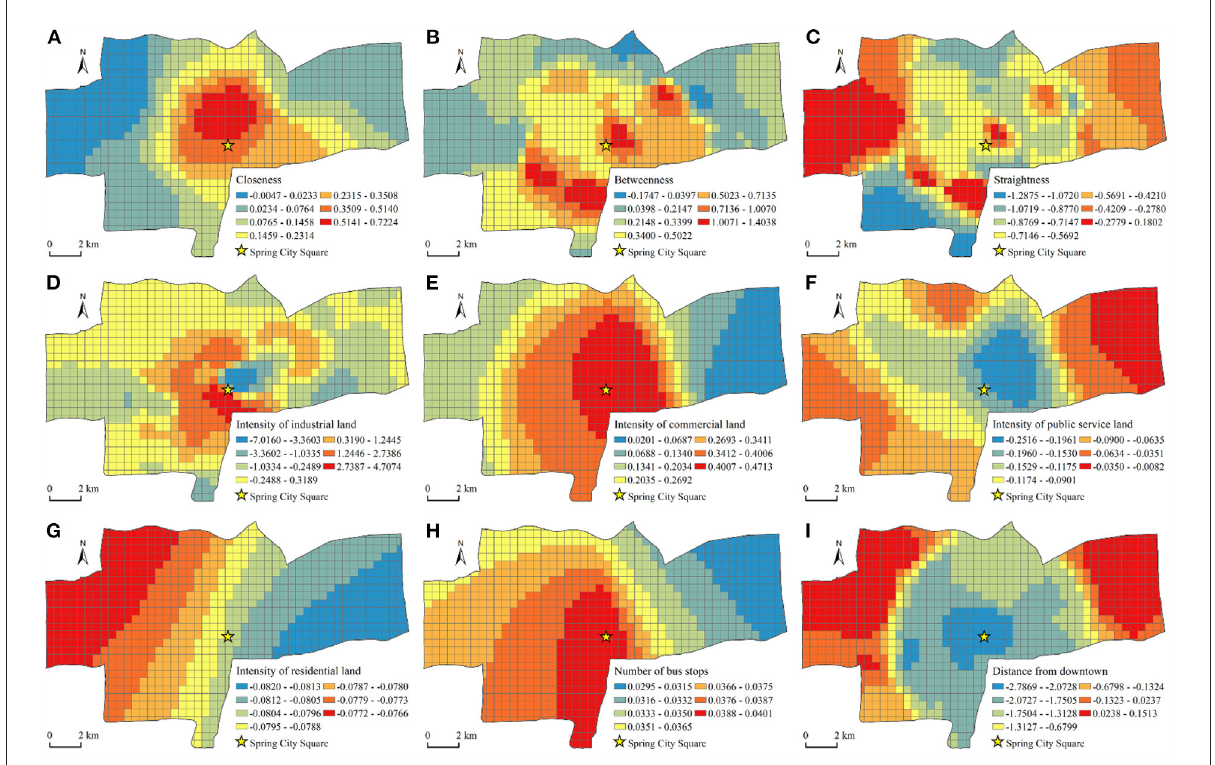
FIGURE6 Spatial pattern of regional coefficients of MGWR variables in the walking mode. (A) Closeness. (B) Betweenness. (C) Straightness. (D) Intensity of industrial land. (E) Intensity of commercial land. (F) Intensity of public service land. (G) Intensity of residential land. (H) Number of bus stops. (I) Distance from